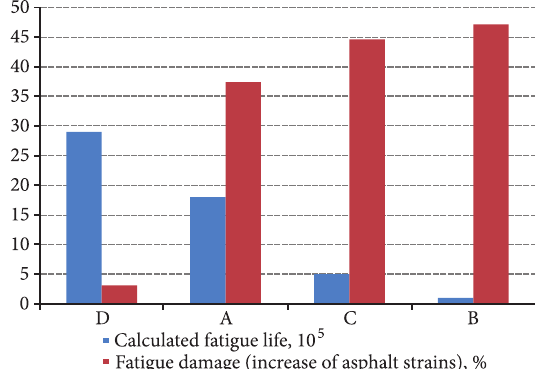
Fig. 9. Comparison of fatigue life for each individual section according to Asphalt Institute method and fatigue life estimated on the basis of strain analysis (under the load of 60 kN – in the beginning and at the end of the HVS